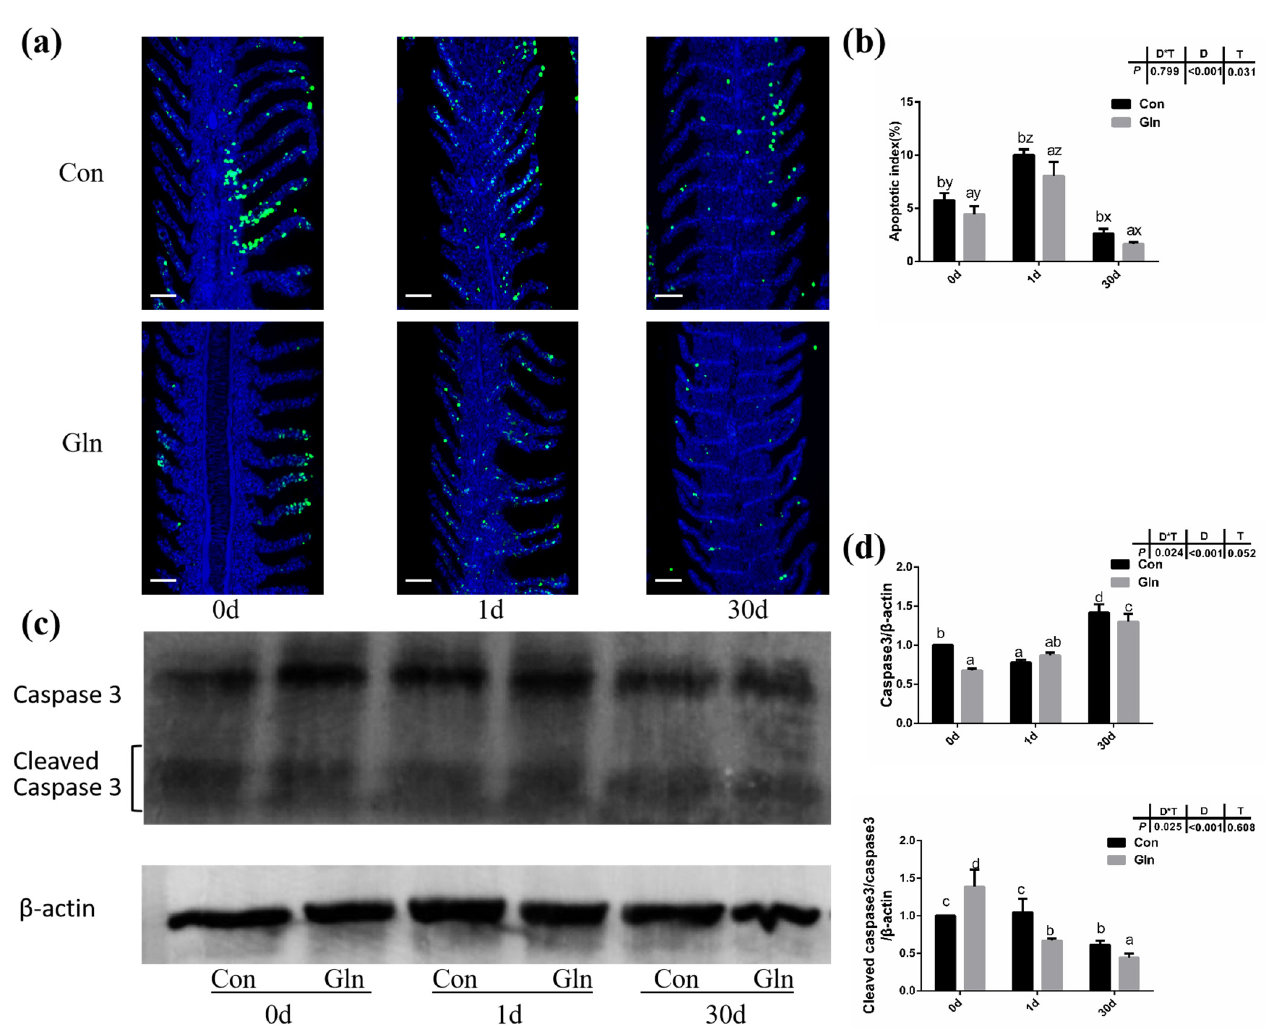
Figure 4. The effects of dietary glutamine on the gill apoptosis of yellow catfish during F. columnare infection. ( a ) TUNEL assay of apoptotic cells in the gill of yellow catfish in both the control group (Con) and glutamine supplementation group (Gln) at 0 d, 1 d and 30 d after F. columnare infection. Stained for apoptosis cells (green), nuclei are stained with DAPI (blue). Scale bar, 100 μ m. ( b ) The apoptotic index of gill cells in yellow catfish among all treatments ( n = 12). ( c ) The Western blotting analysis of caspase-3 and cleaved caspase-3 in yellow catfish among all six treatments. ( d ) The ratio of caspase-3 protein level/ β -actin protein level and the ratio of cleaved caspase-3 protein level/caspase-3 protein level/ β -actin protein level ( n = 6). When significant D*T were observed ( p < 0.05), data were analyzed by one-way ANOVA followed by Tukey’s multiple range tests to inspect differences among all the data, with “a-e” to indicate the significant difference. When the significance is only with the main effects of D or T, “a-e” and “x-z” were labeled to indicate the significant difference among groups in D or T, respectively.